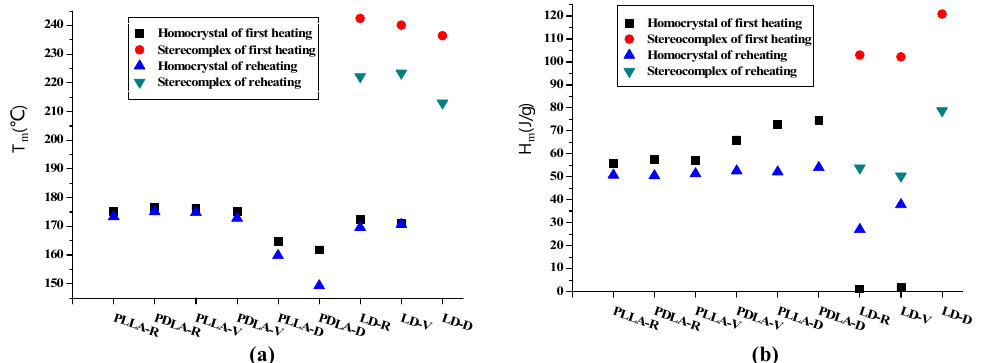
Figure 8. ( a ) Melting peaks and ( b ) melting enthalpy values of the first heating and reheating curves for PLLA, PDLA, and LD at a heating rate of 10 °C/min.